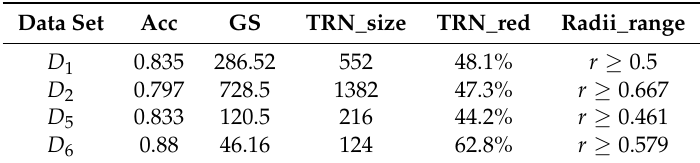
Table 15. Exemplary result for Homogeneous Granulation—5 times Cross Validation 5; k − NN